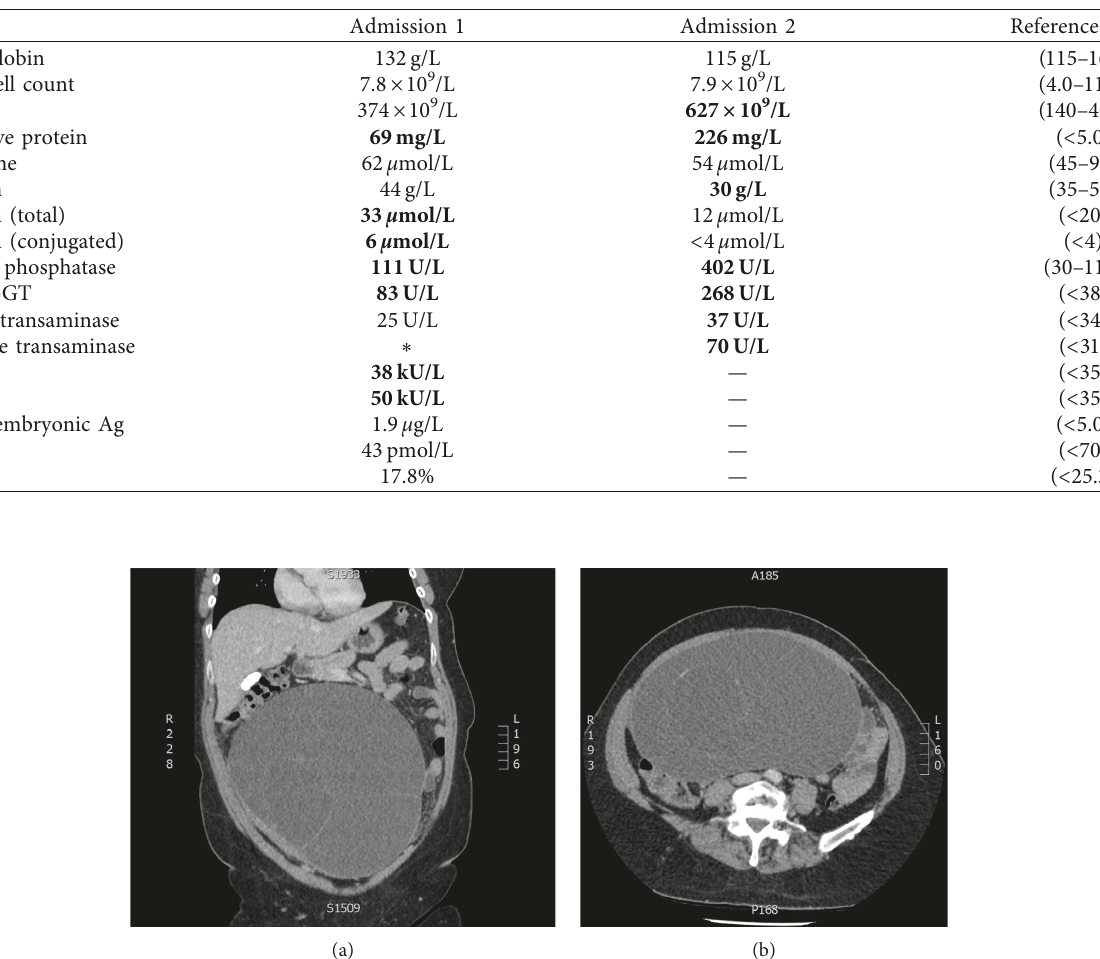
Table 1: Laboratory results.